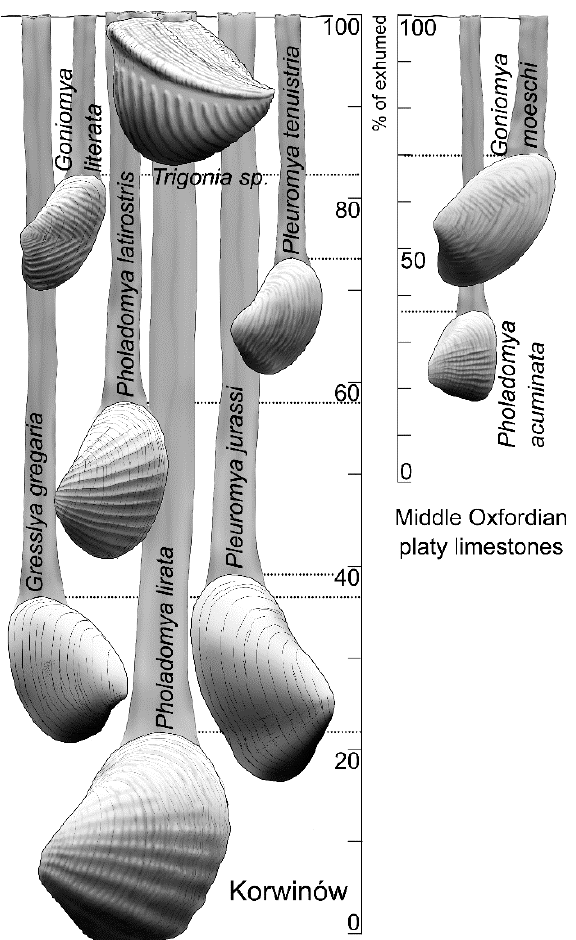
Figure 6. Distribution of the burrowing species (listed in Table 1) in the sediment; a schematic. Burrowing depth shown as relative to the frequency of non-exhumed specimens. Specimen sizes averaged for the species and proportional to each other rather than to the estimated burrowing depth.